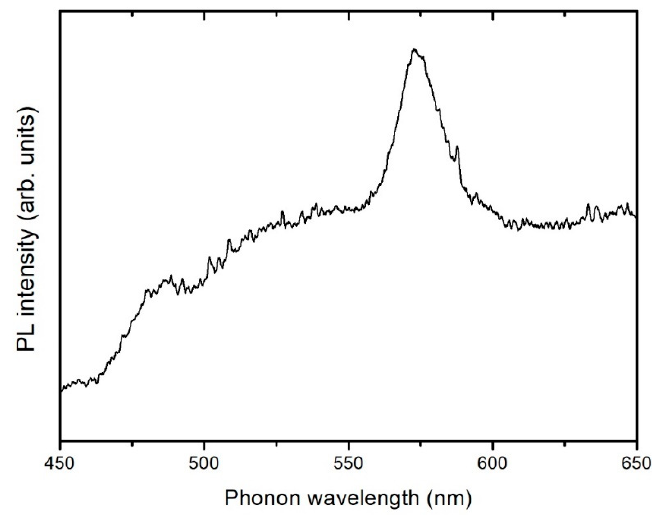
Figure 10. Photoluminescence (PL) spectrum of adsorbed dysprosium onto the AC-PA activated carbon.